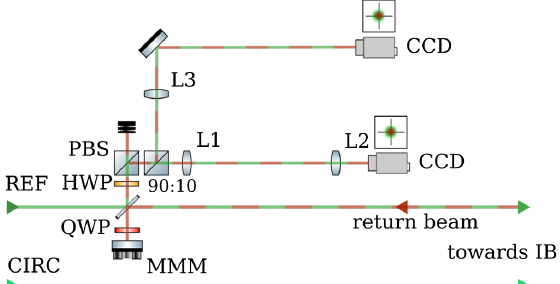
FIG. 17. Optical scheme of the self referenced autocollimator. HWP: half wave plate, PBS: polarized beam splitter, QWP: quarter wave plate, MMM: piezo motorized mirror mount, L1,L3: plano-convex lens, L2: plano-concave lens, CCD: area detectors.